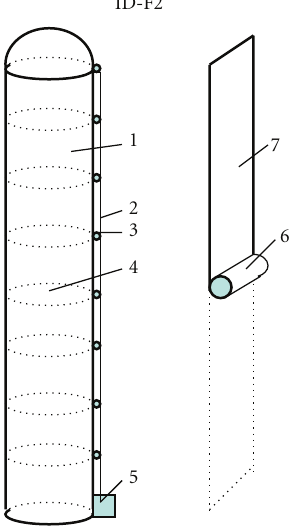
Figure 4: Inflatable column and design of film side wall (left). Film side wall (right). Notations: (1) inflatable column; (2) air tube and control wire; (3) control air valves; (4) internal partition; (5) air pump and control; (6) roll of film; (7) side of wall.